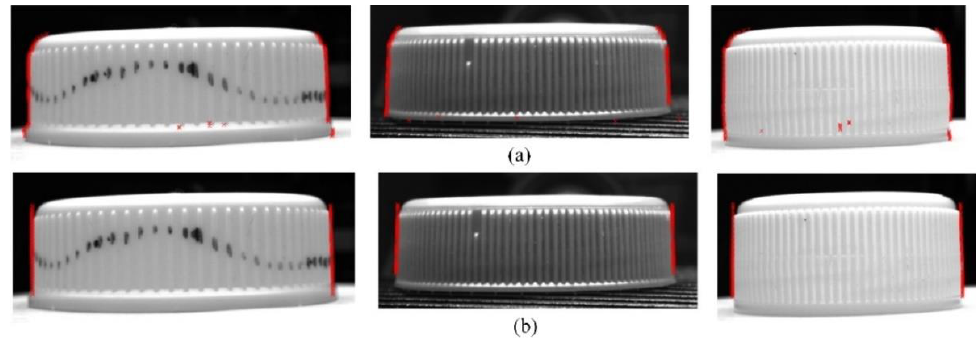
Figure 13. Edge detection results: ( a ) Edge detection results of samples 1, 2 and 3 using our meth- ods; ( b ) Edge detection results of samples 1, 2 and 3 only using the Canny edge detection algo- rithm.